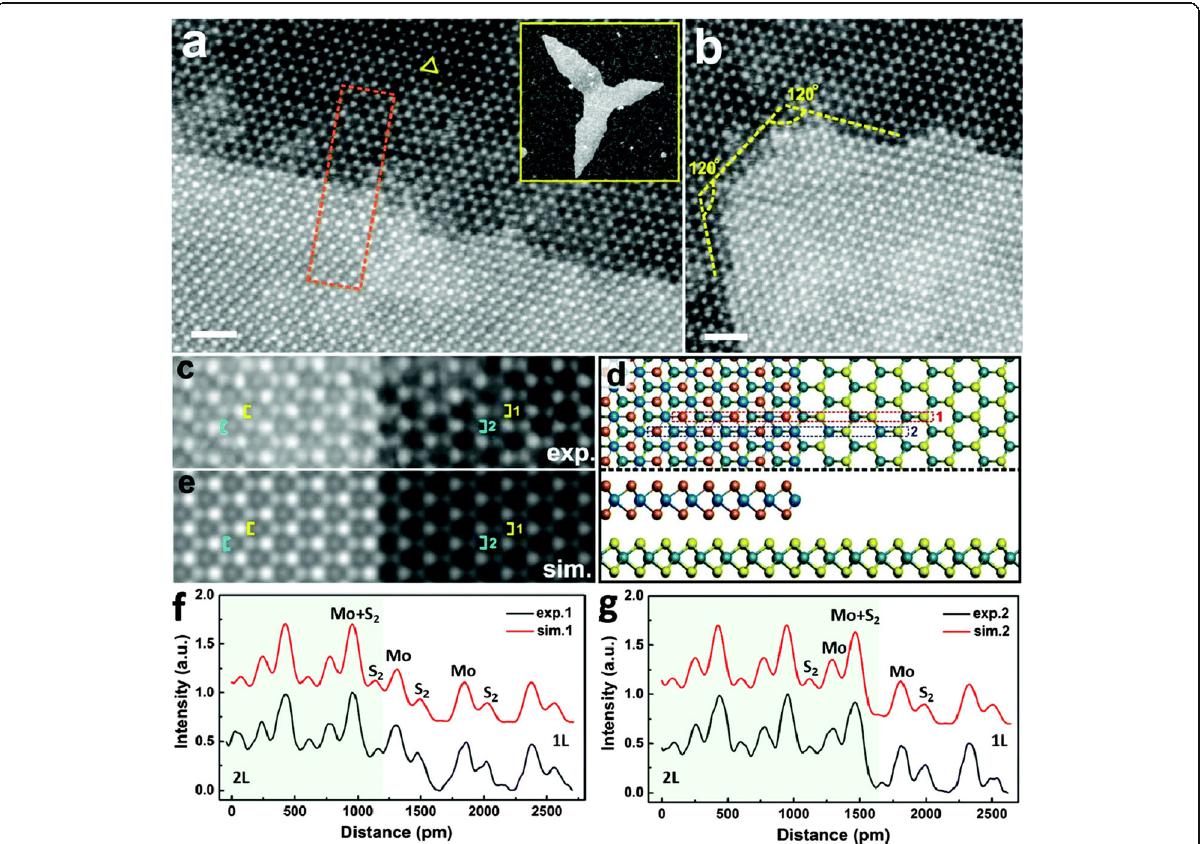
Fig. 1 ADF-STEM images showing stacked bilayer MoS 2 . a ADF-STEM image of the tip region of stacked bilayer MoS 2 . b ADF-STEM image showing the extended bilayer MoS 2 step edge. c Magnified image of the small region in ( a ). d Atomic model based on ( c ) showing both projection and side views. e Multi-slice ADF-STEM image simulation corresponding to the atomic model in ( d ). f Intensity line comparison between the simulated and experimental image of the site terminated with S 2 atoms. g Intensity line comparison between the simulated and experimental image of the site terminated with Mo + S 2 atoms. Reprinted from Wang et al. (2017) ( Nanoscale 9, 13,060 – 13,068) with Nanoscale ’ s